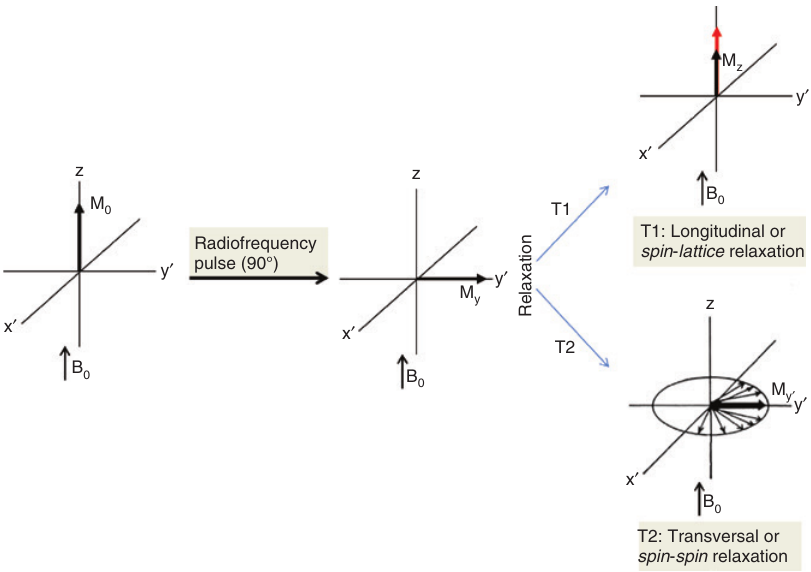
Figure 15: Magnetization vector M at thermal equilibrium, followed by a 90 ° RF excitation pulse and relaxation via spin-lattice and spin-spin interactions.